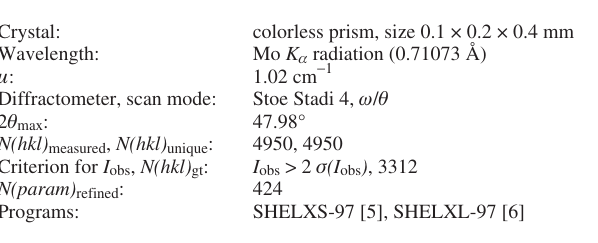
Table 1. Data collection and handling.